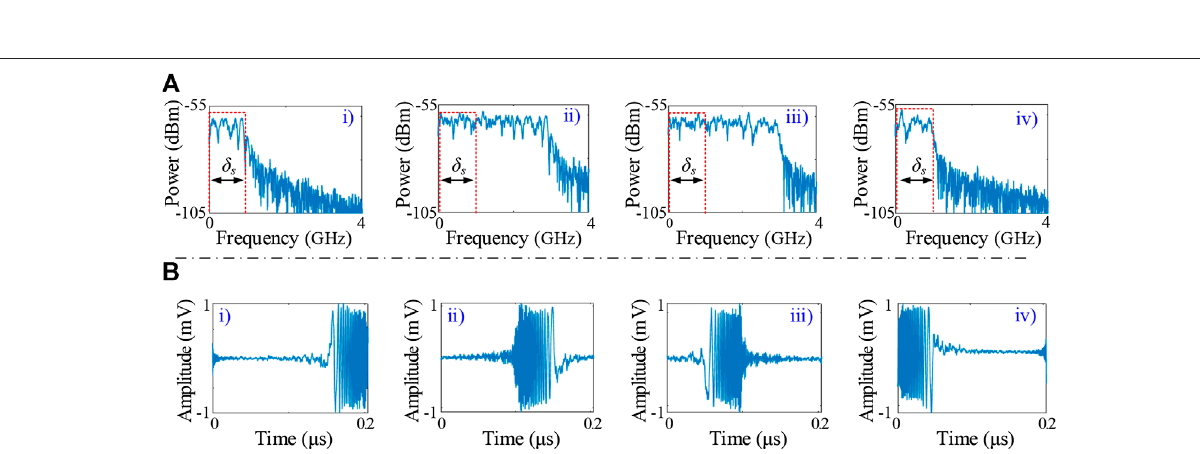
Frontiers in Physics |